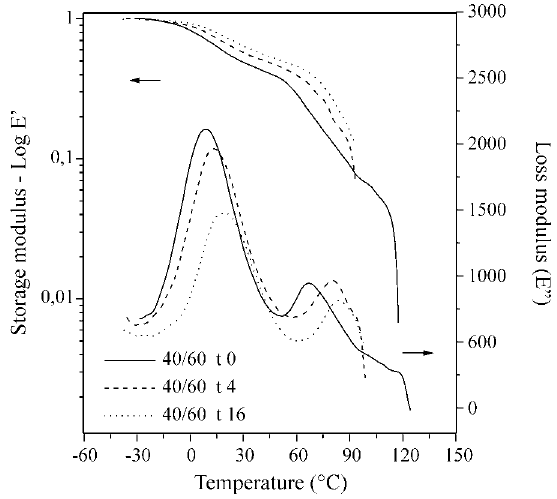
Figure 6. DMA curves for PLLA/PHBV 40/60 blends in relation to degradation periods 0, 4, 16 weeks.